Question: Draft a figure caption describing what is shown.
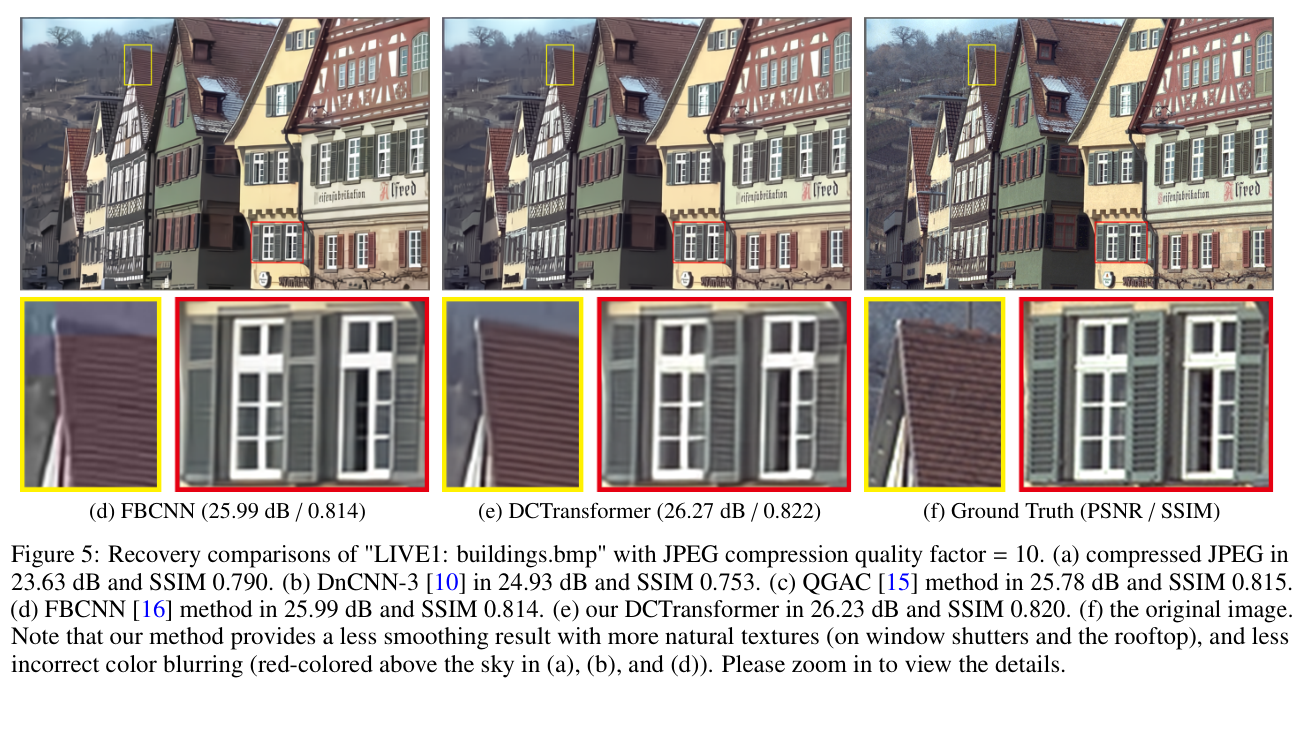
Answer: presents another comparison of the results for artifact removal. The channel residual refers to the difference between the recovered images and the corresponding ground truth. We convert the recovered results to YCbCr colorspace and present the residual of each channel separately. Through this example, we highlight that the proposed DCT domain method is able to handle color components quite well. It is worth emphasizing that since our method generates upsampled chrominance components in the DCT domain, the recovery result from our method shows a more consistent color with the ground truth, i.e. less red-colored blurring in the area of the sky. That also demonstrates the design of luminance-chrominance alignment has an advantage in eliminating large area color artifacts, which eventually produces a more visually pleasing restoration.